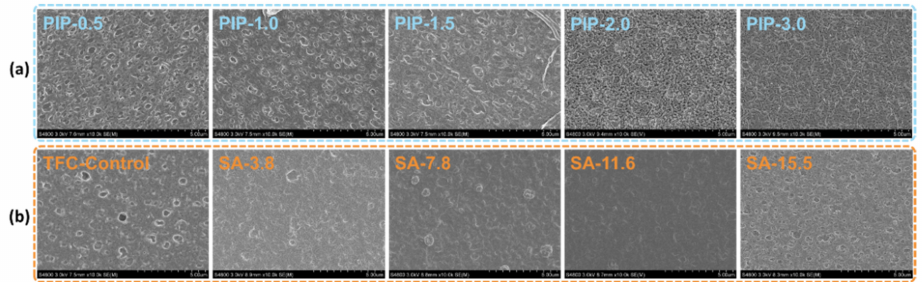
Figure 2. Surface topography of SA–TFC membranes synthesized at different concentrations of ( a ) PIP (SA is fixed at 15.5 g/L) and ( b ) SA (PIP is fixed at 1.5 g/L).